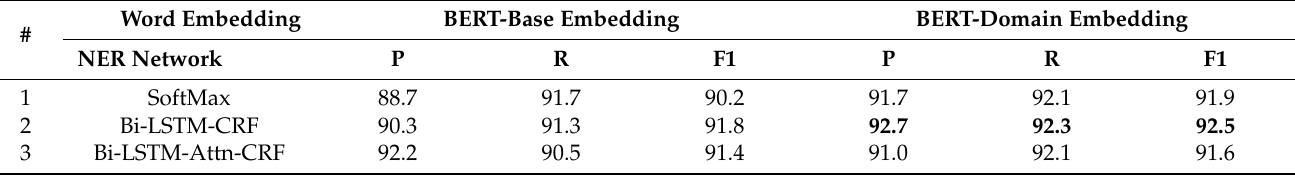
Table 3. Summary of experimental results for MenuNER with (BERT-base-cased) and target domain-adapted version (BERT-domain) on NER task model. We utilize feature-based BERT model with extended features for NER network 2 and 3 while fine-tuning BERT model on downstream dataset for network 1.